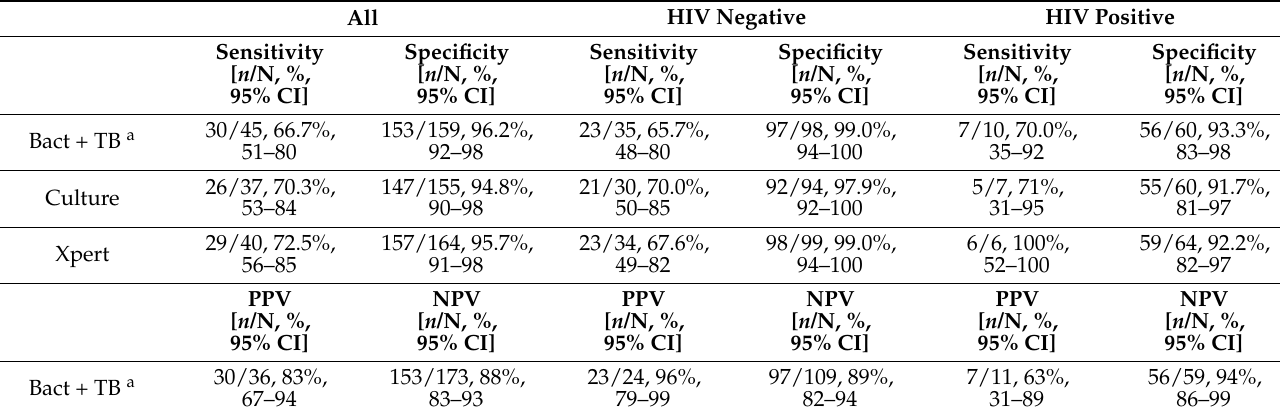
Table 3. Sensitivity and specificity of FujiLAM test by HIV status.